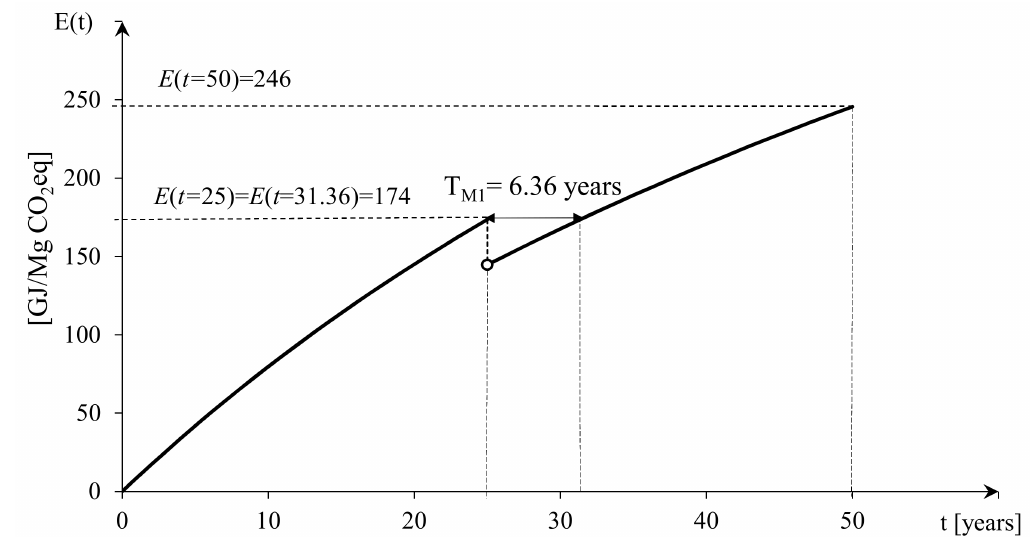
Figure 4. A graphical interpretation of the integrated e ffi ciency indicator from ecological costs for a wind power plant undergoing modernization during a 50-year period of use.